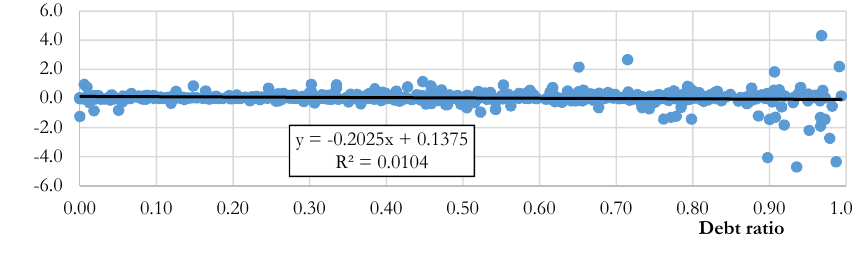
Fig. 5 – Relationship of ROE and debt ratio in the business sector F – Construction. Source: Own investigation.